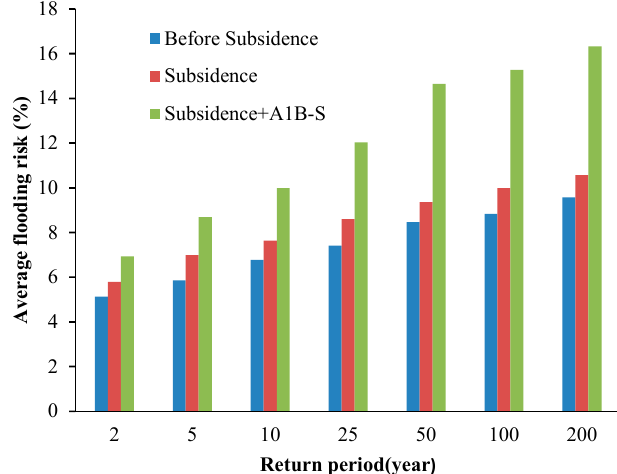
Figure 18. Average inundation risk for a two-day storm under different return periods and scenarios.